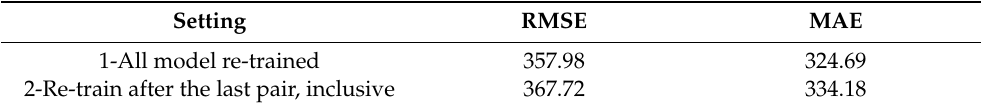
Table 9. Results of the pre-trained CNN (Convolutional Neural Networks) model on the second WWTP (Wastewater Treatment Plants).